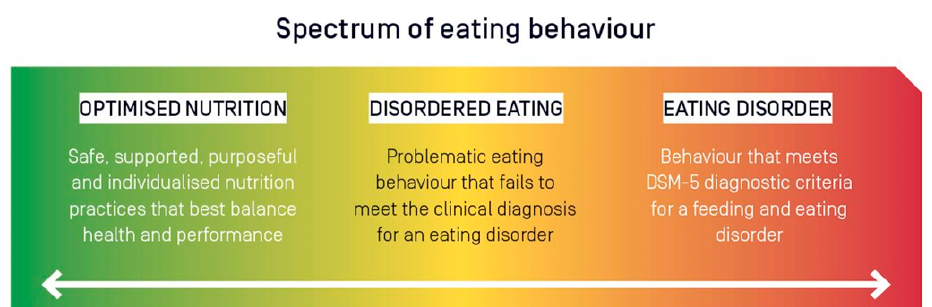
Figure 2. The spectrum of eating behaviour in the high performance athlete from optimised nutrition to disordered eating to eating disorders. DSM-5, Diagnostic and Statistical Manual of Mental Disorders, Fifth Edition. Figure originally published by: Wells, K.R., et al. The Australian Institute of Sport (AIS) and National Eating Disorders Collaboration position statement on disordered eating in high performance sport. Br. J. Sports Med. 2020 Nov; 54(21):